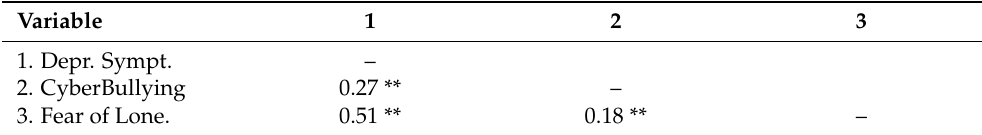
Table 2. Model variables correlation matrix.